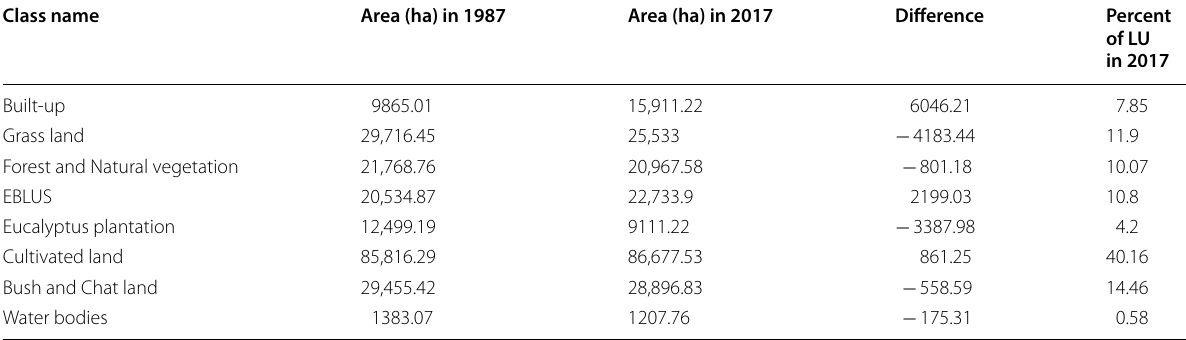
Table 6 Percent of Land use land cover and changes